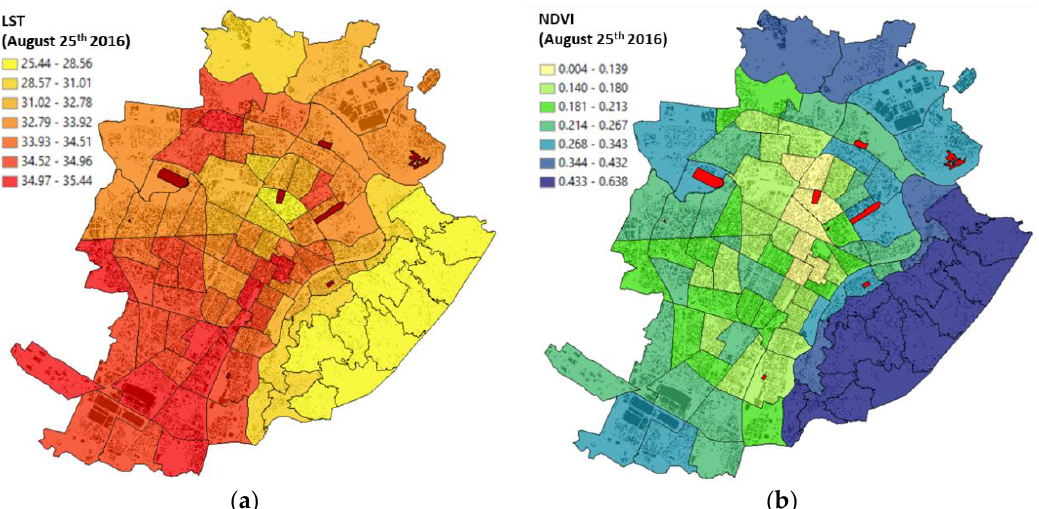
Figure 17. Analysis at statistical area scale: ( a ) LST; ( b ) NDVI; in red the empty industrial spaces were indicated.